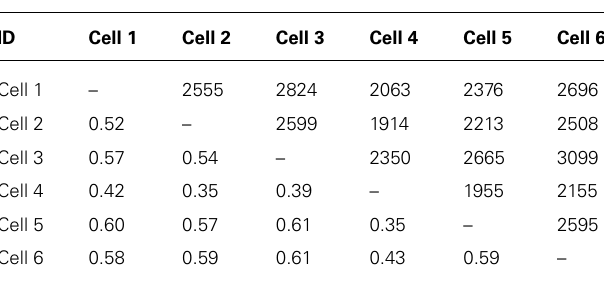
Table 3 | Pairwise Spearman’s rank correlation coefficient for between all neuronal cells from cell cultures. ID